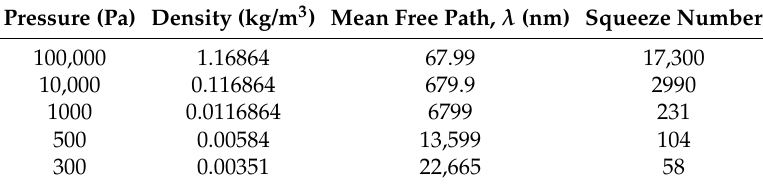
Table A3. Squeeze number at different pressure